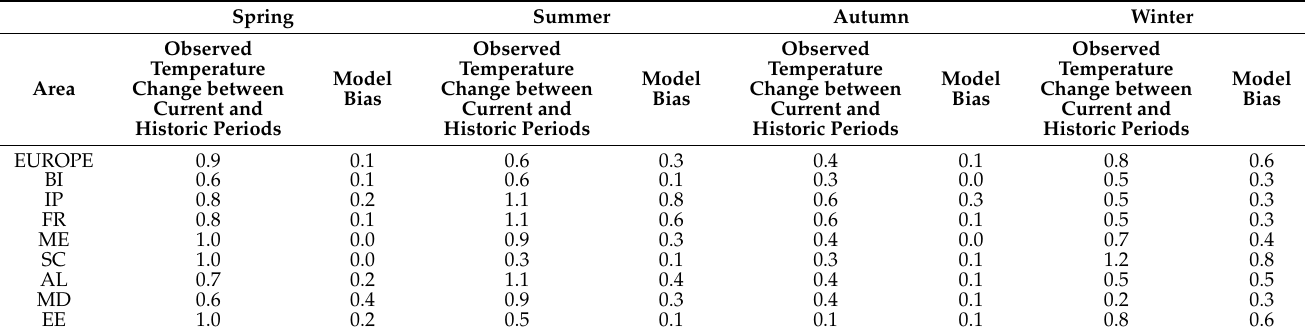
Table 3. Same as Table 2 but for each season